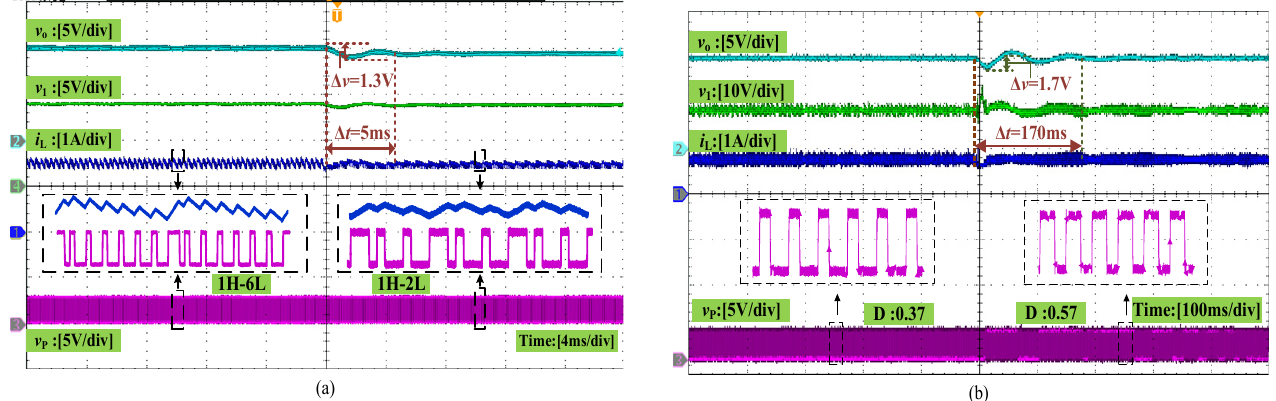
Figure 15. Experimental waveform with the input voltage changes with ( a ) the proposed CC&OV-PT control and ( b ) the conventional PWM control.